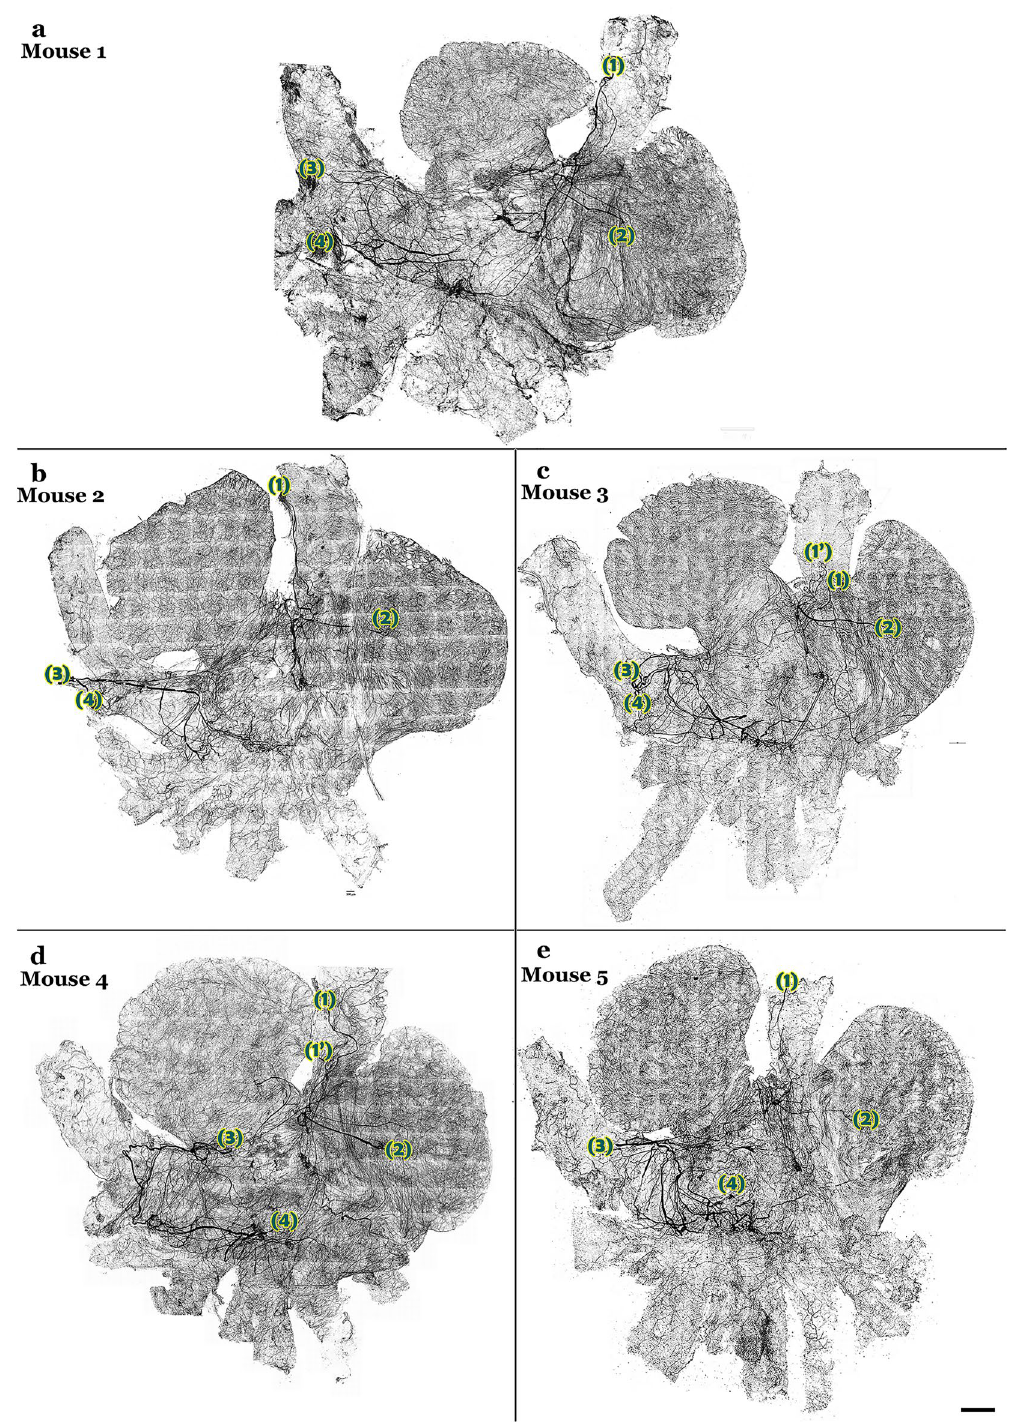
Figure 3. Comparison of TH-IR axon innervation across five animals. Large TH-IR bundles entered the atria mainly through the SVC (bundles 1, 2), LPCV (bundle 3) or the entrance of the PVs to LA (bundle 4). The bundles entering the RA mainly sent their projections to innervate the right atrium, whereas bundles entering the LPCV mainly extended their projections towards the LA. A certain degree of overlap of innervation could be seen in the junction of LA and RA, SA, and AVN. Note: some fibers could have been cut or folded during the dissection which contributed to the few differences across animals. 1’ indicates the additional bundle found in some animals near bundle. Scale bar: 500